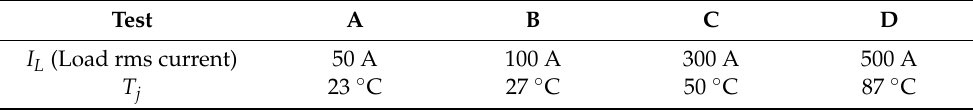
Table 7. Test conditions, V DC = 500–700